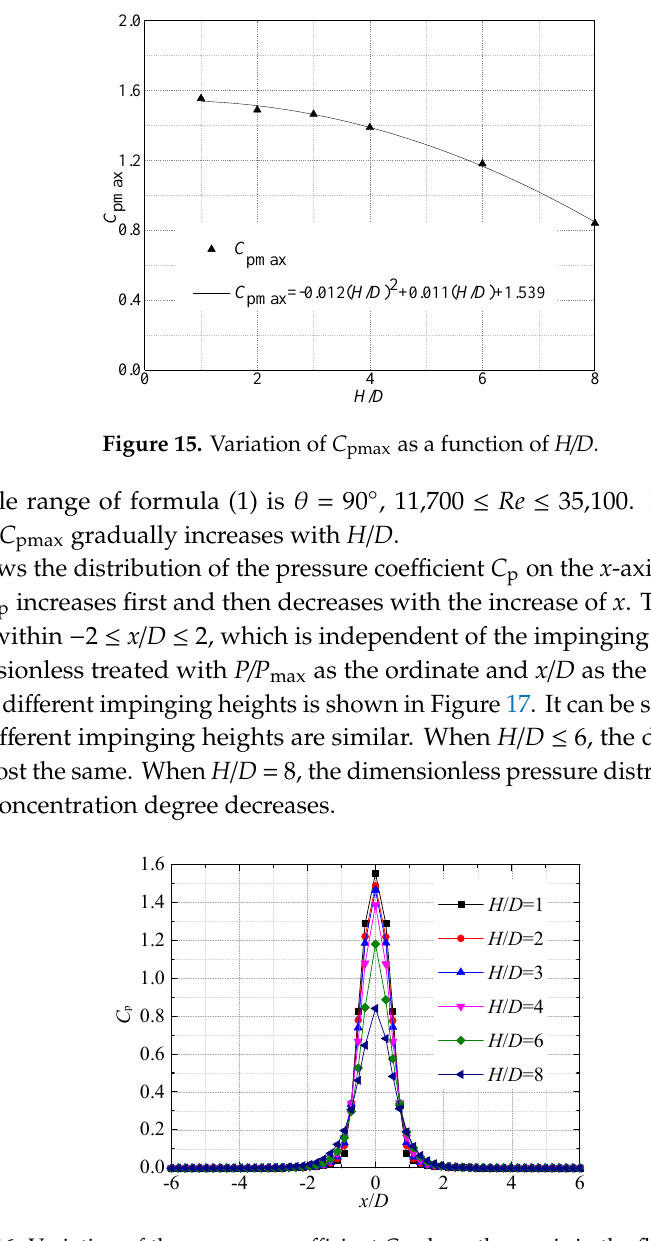
Figure 14. Pressure contour of the plane ( oxy plane) of jet at various impinging height:( a ) H / D = 1; ( b ) H / D = 2; ( c ) H / D = 3; ( d ) H / D = 4; ( e ) H / D = 6; ( f ) H / D = 8.